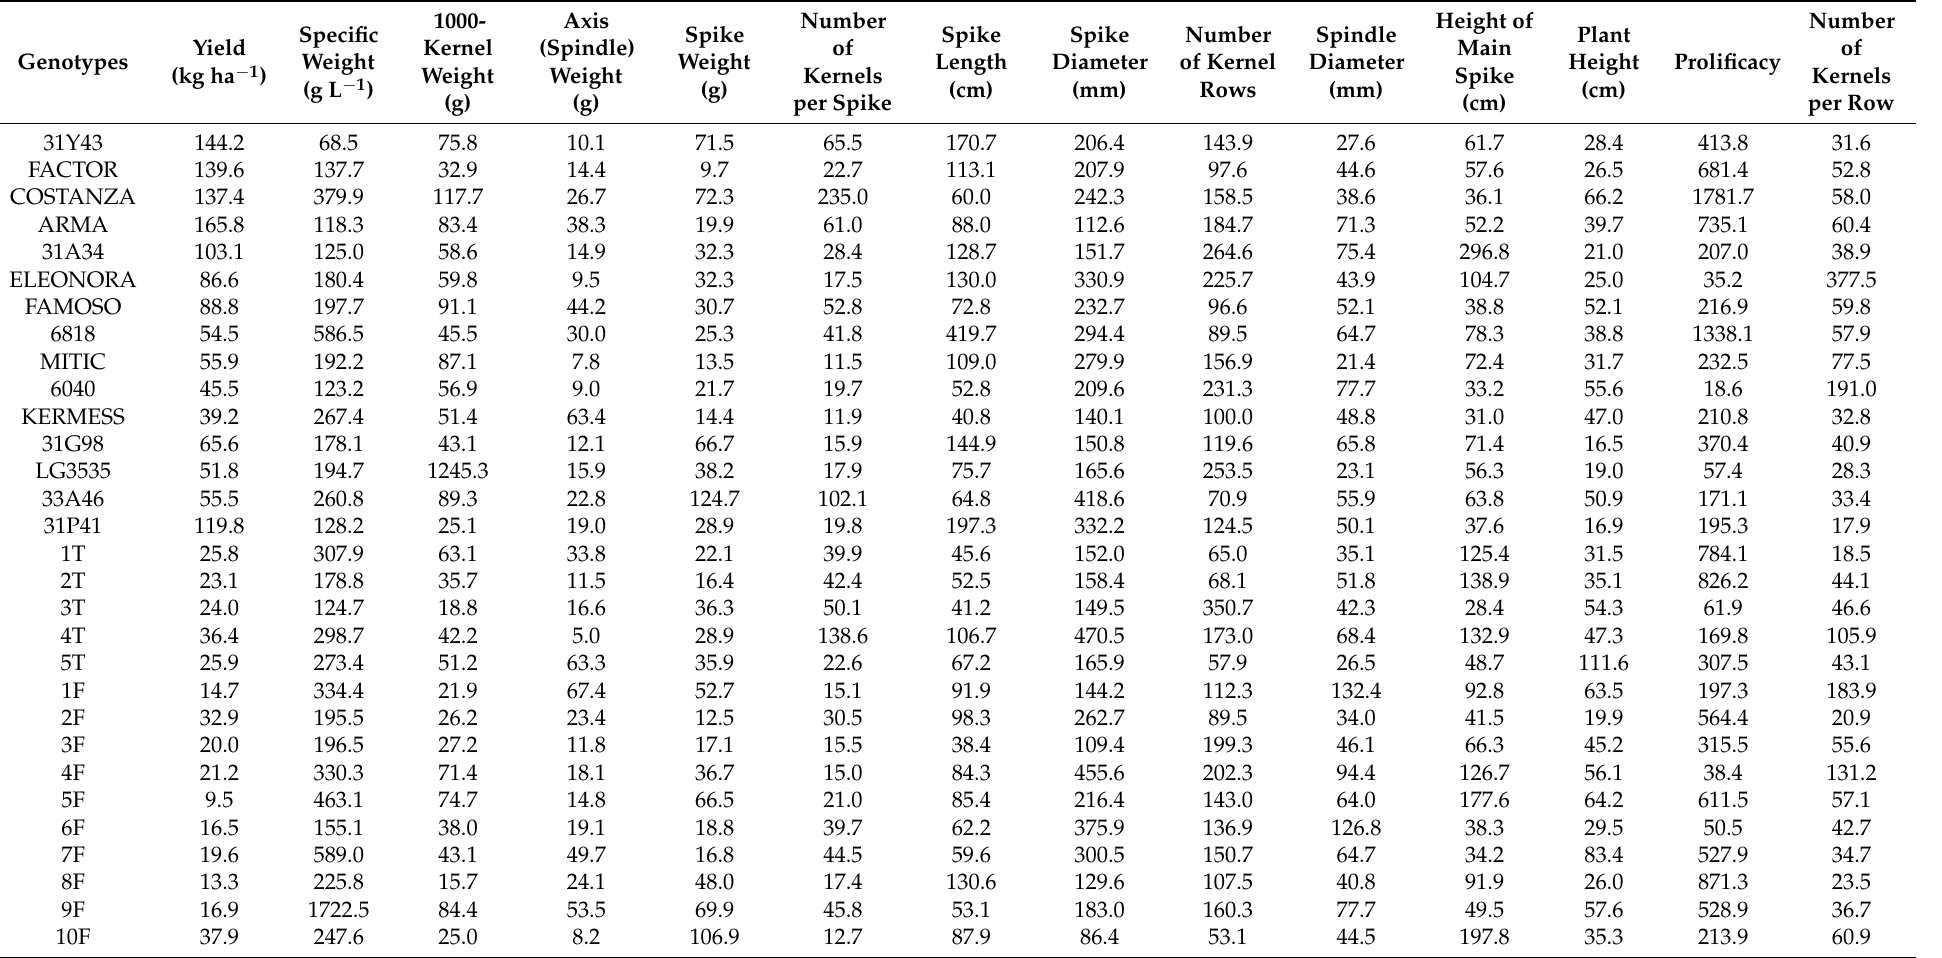
Table 3. Trait stability index ( x / s ) 2 across genotypes and environments for tested traits: yield (kg ha − 1 ), specific weight (g L − 1 ), 1000-kernel weight (g), axis (spindle) weight (g), spike weight (g), number of kernels per spike, spike length (cm) and diameter (mm), number of kernel rows, spindle diameter (mm), main spike and plant height (cm), prolificacy, and number of kernels per row, in Giannitsa